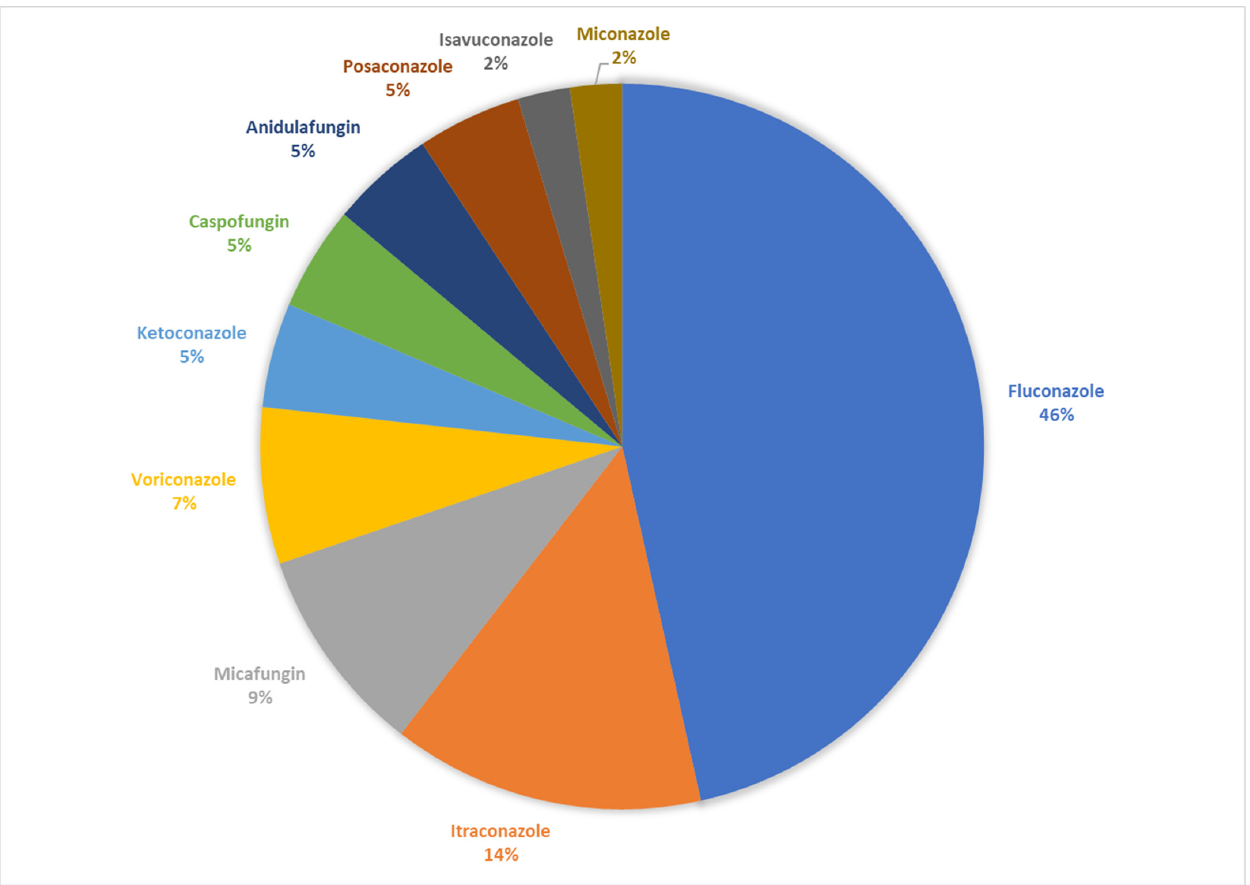
Figure 2. Antifungal resistance to C. glabrata in Ibero-American countries. These data correspond mainly to the isolates of C. glabrata obtained from different populations (women, children, hospitalized people, those with burns, etc.) with superficial (oral, vulvovaginal) or invasive (candidemia) candidiasis.